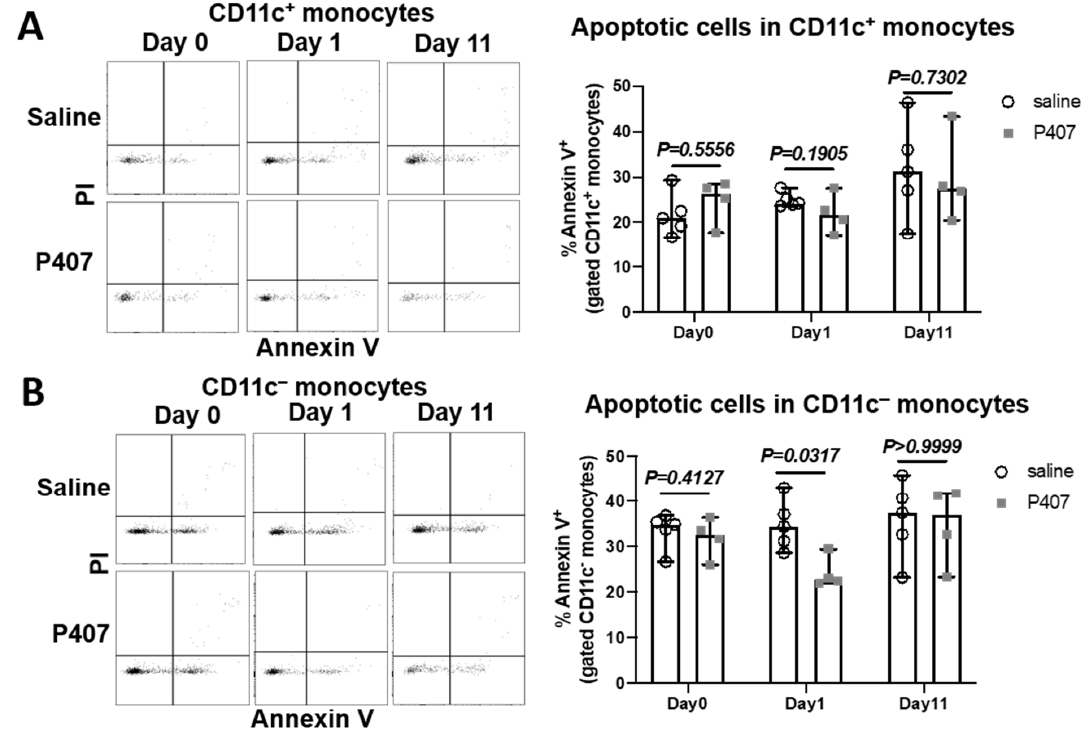
Figure 5. Monocyte apoptosis in Ldlr –/– mice with P407 injection. FACS examples showing annexin